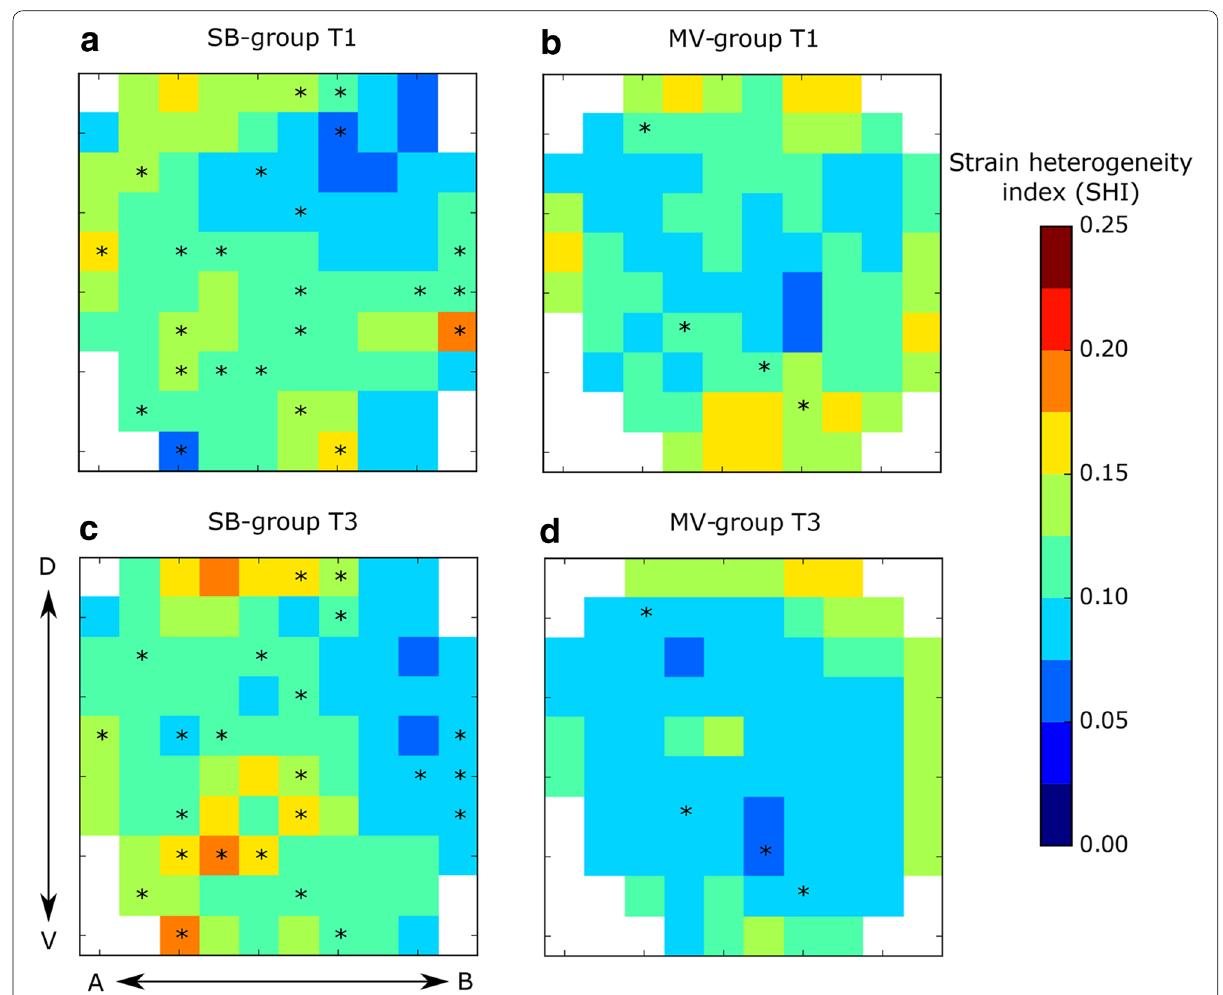
Fig. 4 ROI array maps of the strain heterogeneity index (SHI). a SB‑group at T1, b MV‑group at T1, c SB‑group at T3, d MV‑group at T3. Significant within‑subject differences are denoted by * ( p <